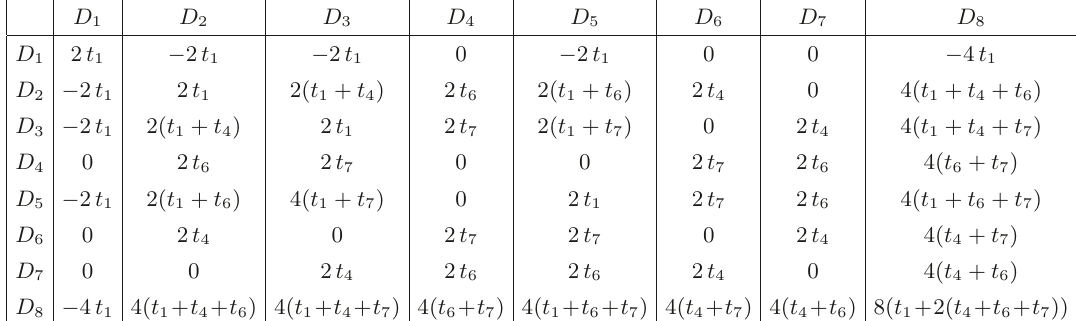
Table 2 . Volumes of intersection curves between two coordinate divisors.